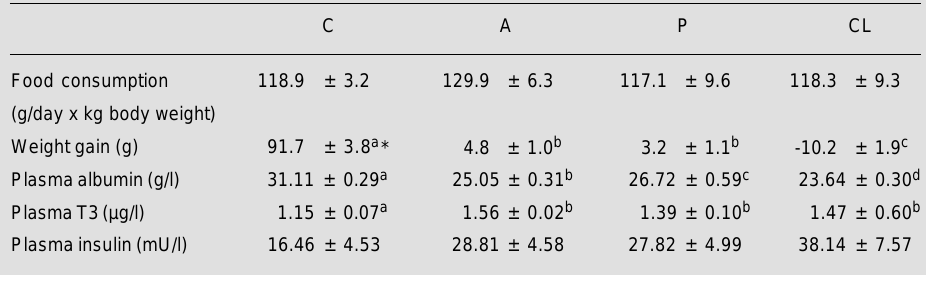
Table 2 - Effect of clenbuterol (CL) on food consumption, weight gain and plasma measurements. Results are reported as means ± SEM for 6 animals per group. Group C: Normally fed control rats; group A: low-protein with free access to food; group P: pair-fed with group CL; group CL: low-protein diet + Cl for 2 weeks. *Values on the same row not sharing a common superscript are significantly different (ANOVA followed by Fisher’s least-significant-difference test).